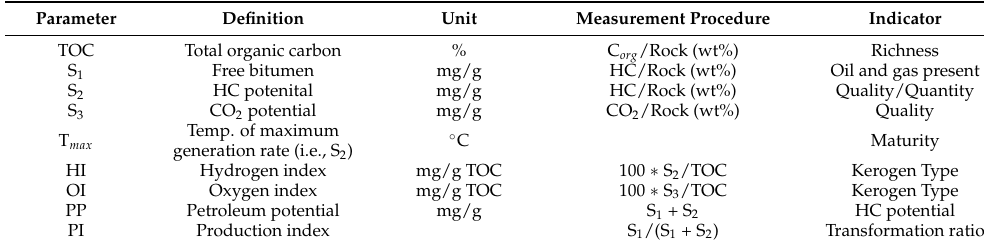
Table 2. Rock–Eval parameters and evaluation